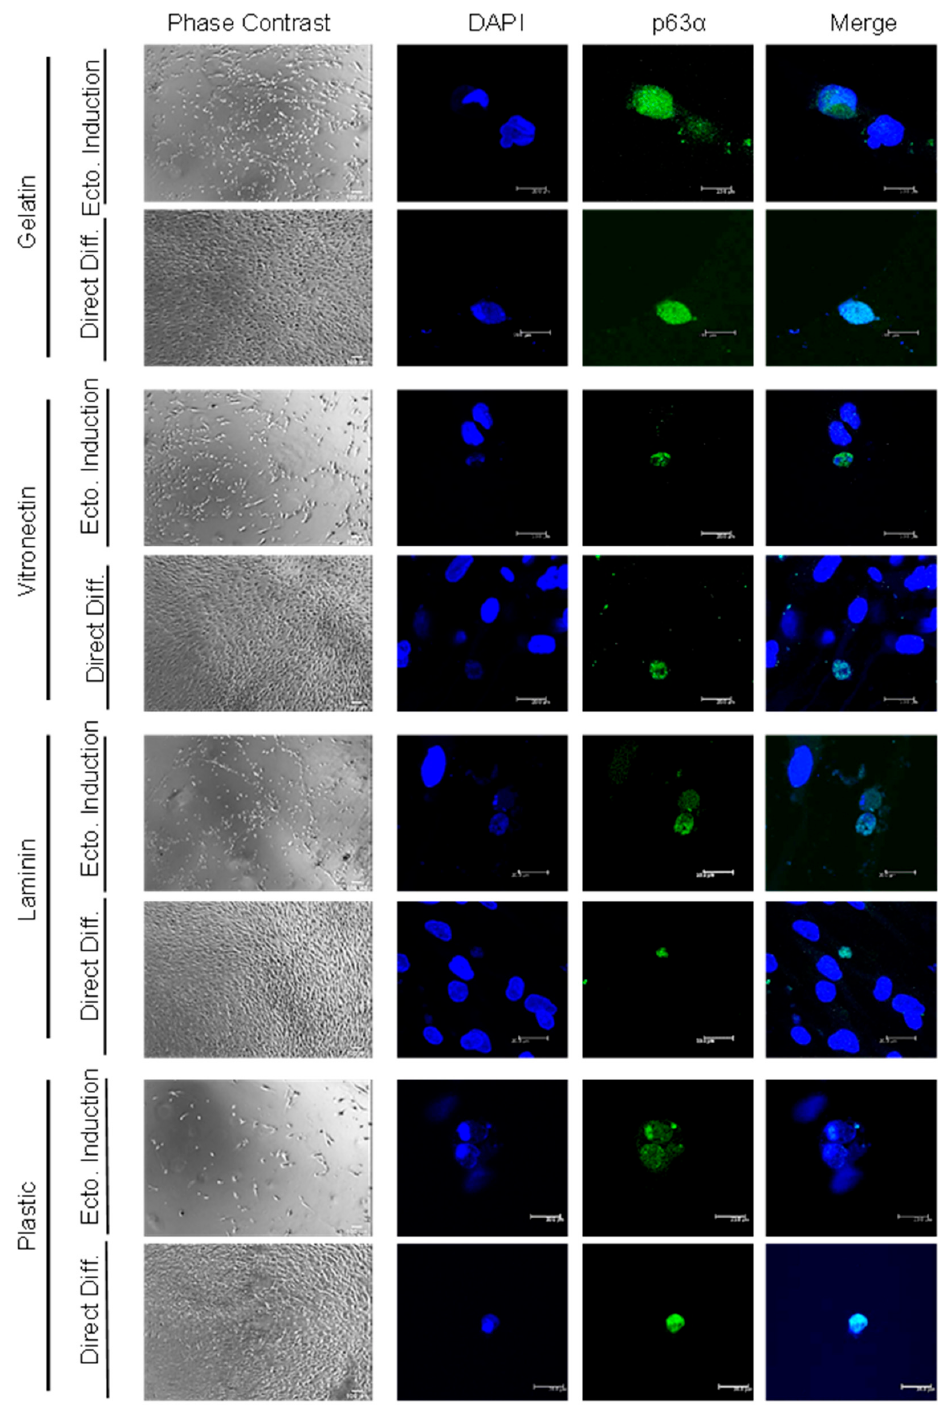
Figure 2. p63 α immunofluorescence of c-Kit-positive hADSC-derived LSCs . Representative phase contrast and confocal microscopy images of c-Kit-positive hADSCs seeded on various coatings (gelatin, vitronectin, laminin and plastic) after employing 2 different culture methods: differentiation after ectodermal induction (Ecto. Induction) or direct differentiation (Direct Diff.); p63 α in green and nuclei in blue; scale bar 200 μ m (phase contrast) and 20 μ m (immunofluorescence images).